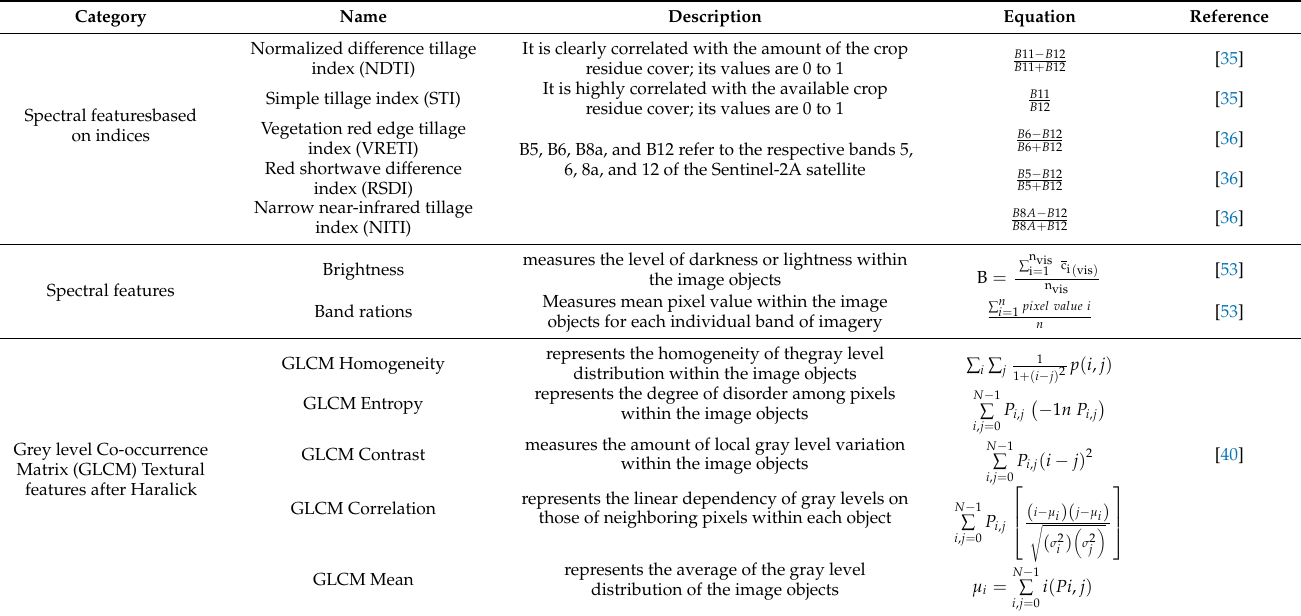
Table 2. Applied spectral and textural features space for the fuzzy object based image analysis (OBIA) classification process.